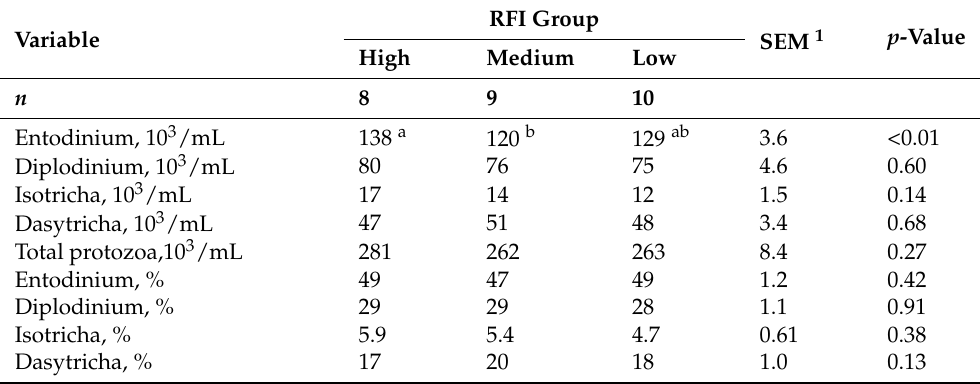
Table 5. Differential counts of ciliated protozoa (10 3 /mL) of Nellore yearling bulls consuming high-concentrate diets classified by residual feed intake